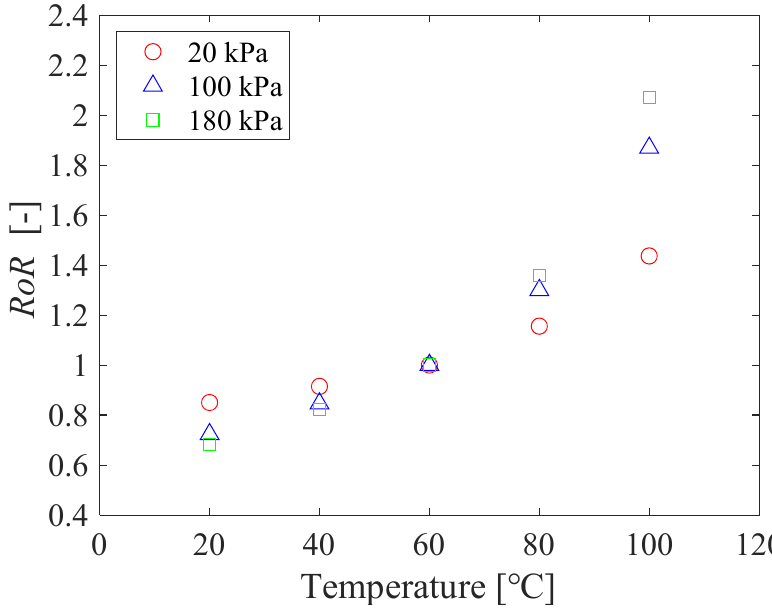
Figure 14. The relationship between the temperature and the RoR of PC-PSP with 0.5 g of urethane resin.